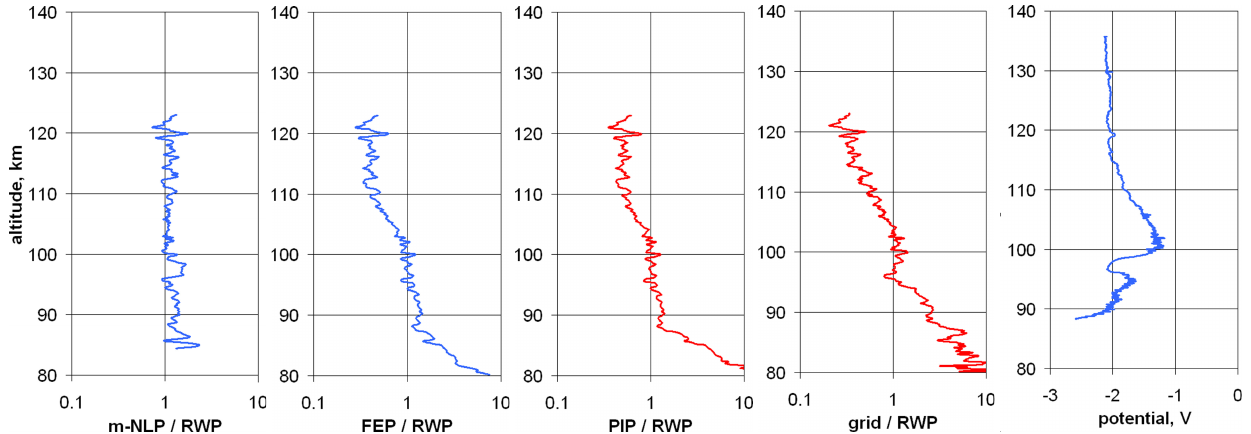
Fig. 4. Residual deviation from the RWP profile as a function of altitude of the various probes together with the measured payload potential (flight